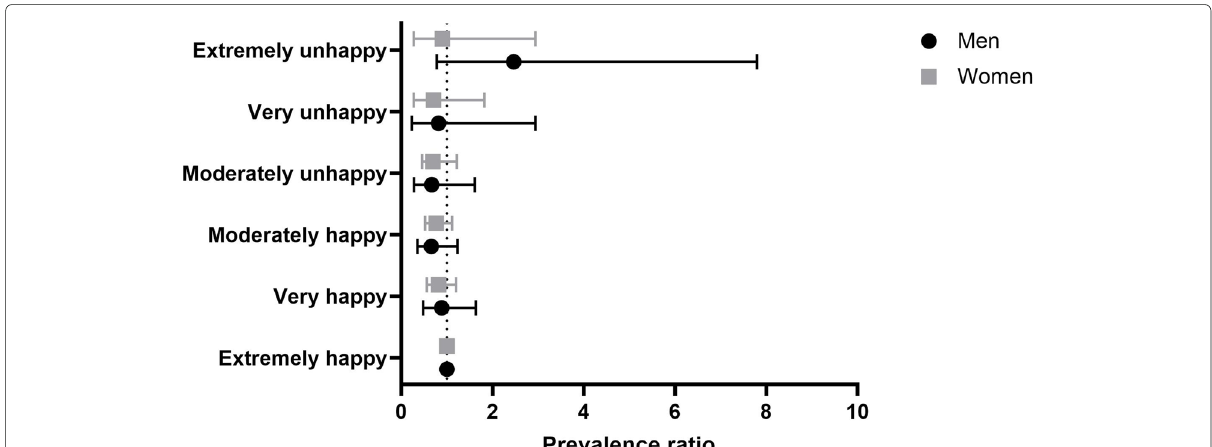
Fig. 6 Forest plot illustrating the prevalence of migraine among participants divided by different degrees of job satisfaction. Mean with error bars plots of the data from Table 6. The point estimate is the prevalence ratio (fully adjusted model) of migraineurs compared with controls among different levels of job